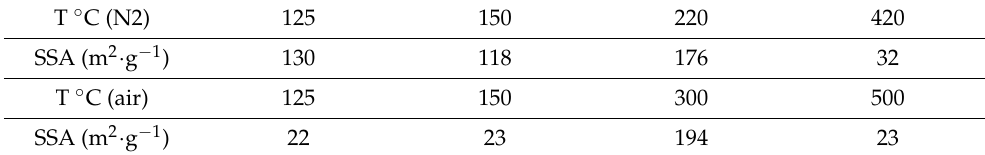
Table 6. The specific surface area of intermediates formed at different temperatures under air and N 2.